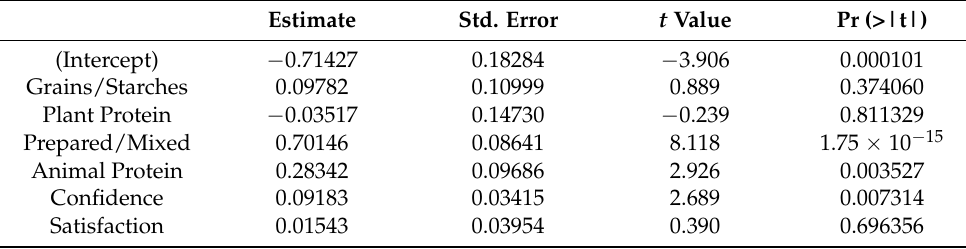
Table 2. Model predicting standardized amount of food taken—regression results.